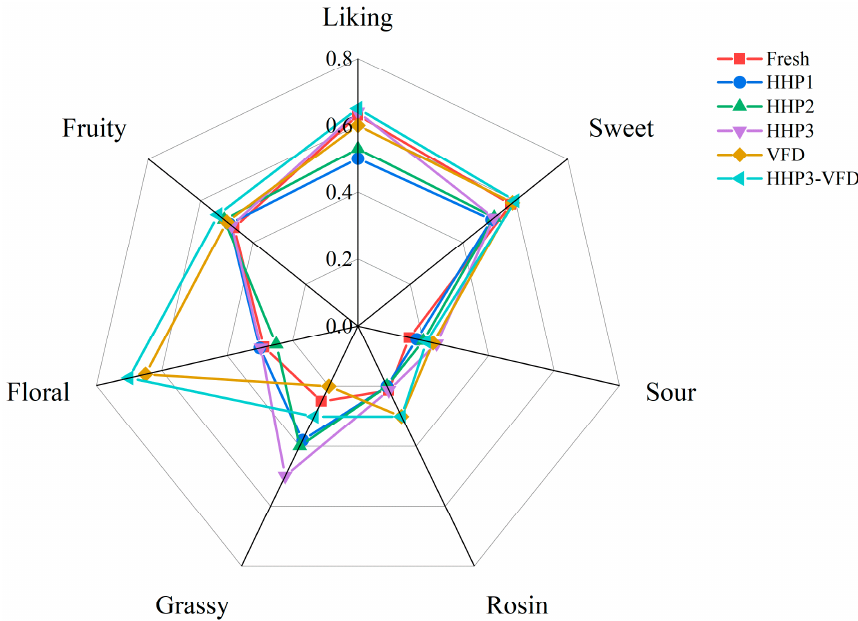
Figure 6. Sensory characteristics of blended juices prepared by different processing methods via QDA.